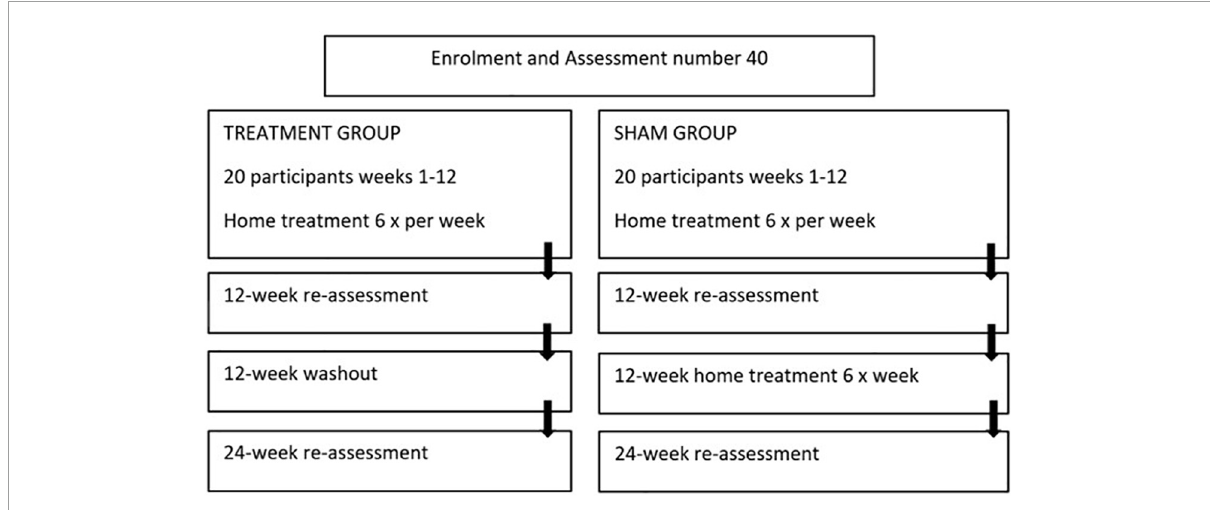
FIGURE3 Protocol for recruitment selection and initial screening and baseline data